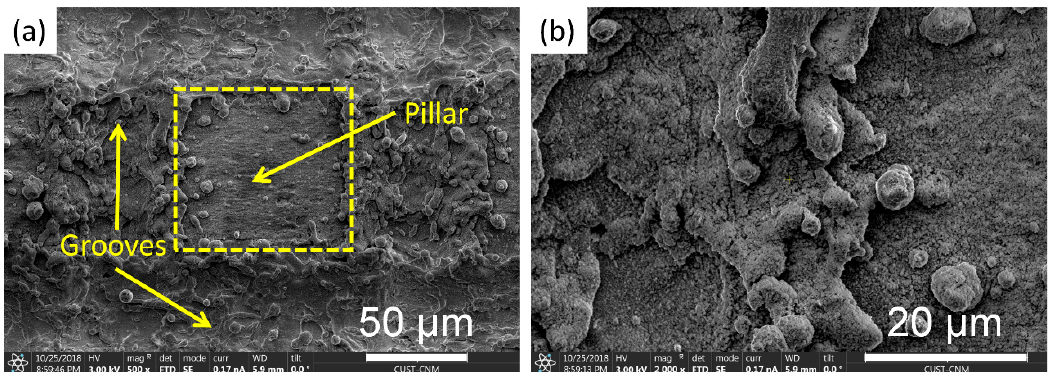
Figure 3. The morphology of the super-hydrophobic surface after laser ablation treatment. ( a ) Magnification of 500×; ( b ) Magnification of 2000×.